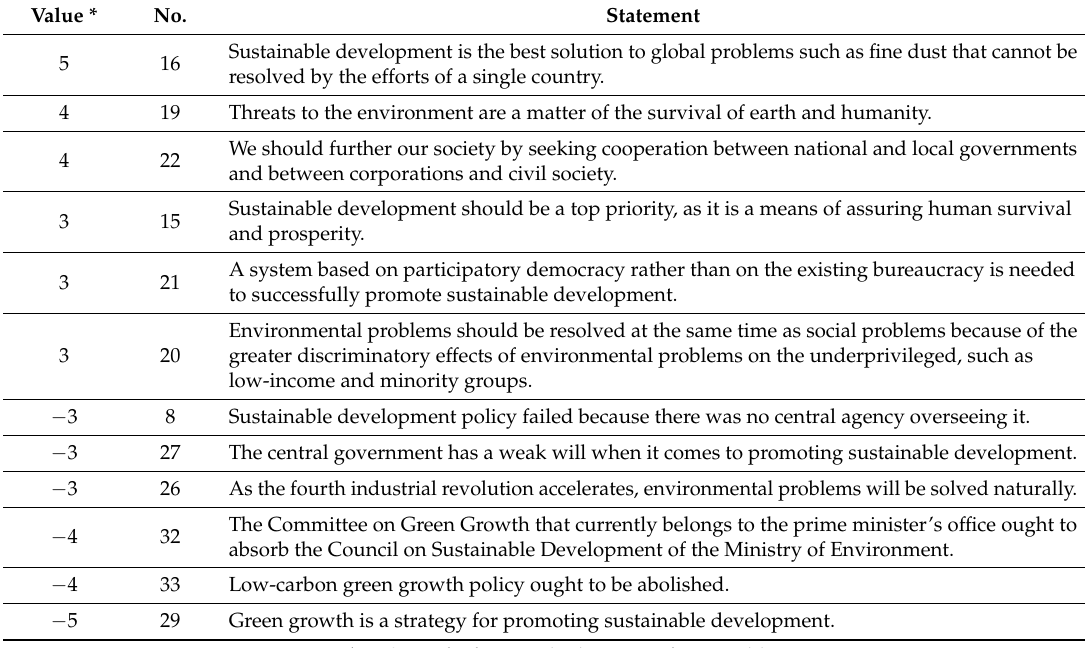
Table 7. Idealists’ Q